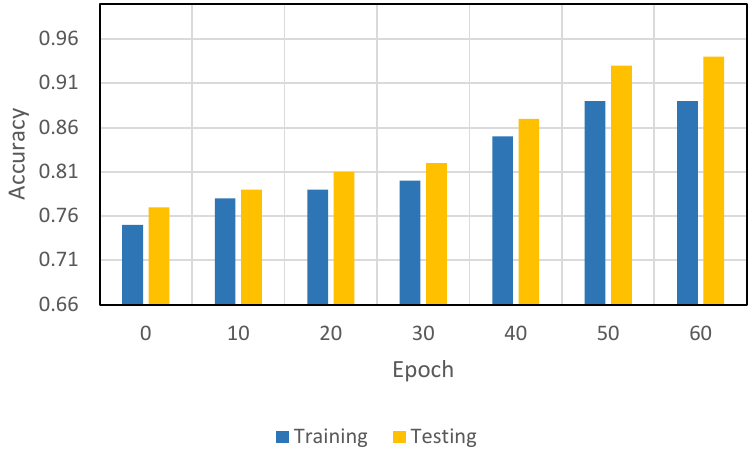
Figure 6. Accuracy of the proposed model both in the training and testing phases, taking into account live CT scan imaging datasets.